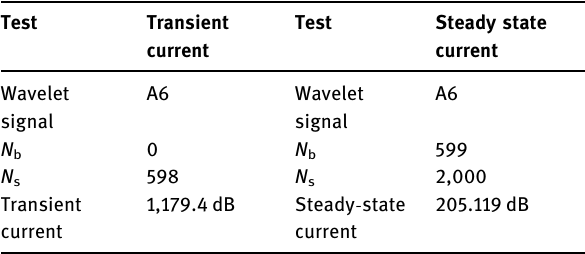
Table 2: Calculation of degree of severity level